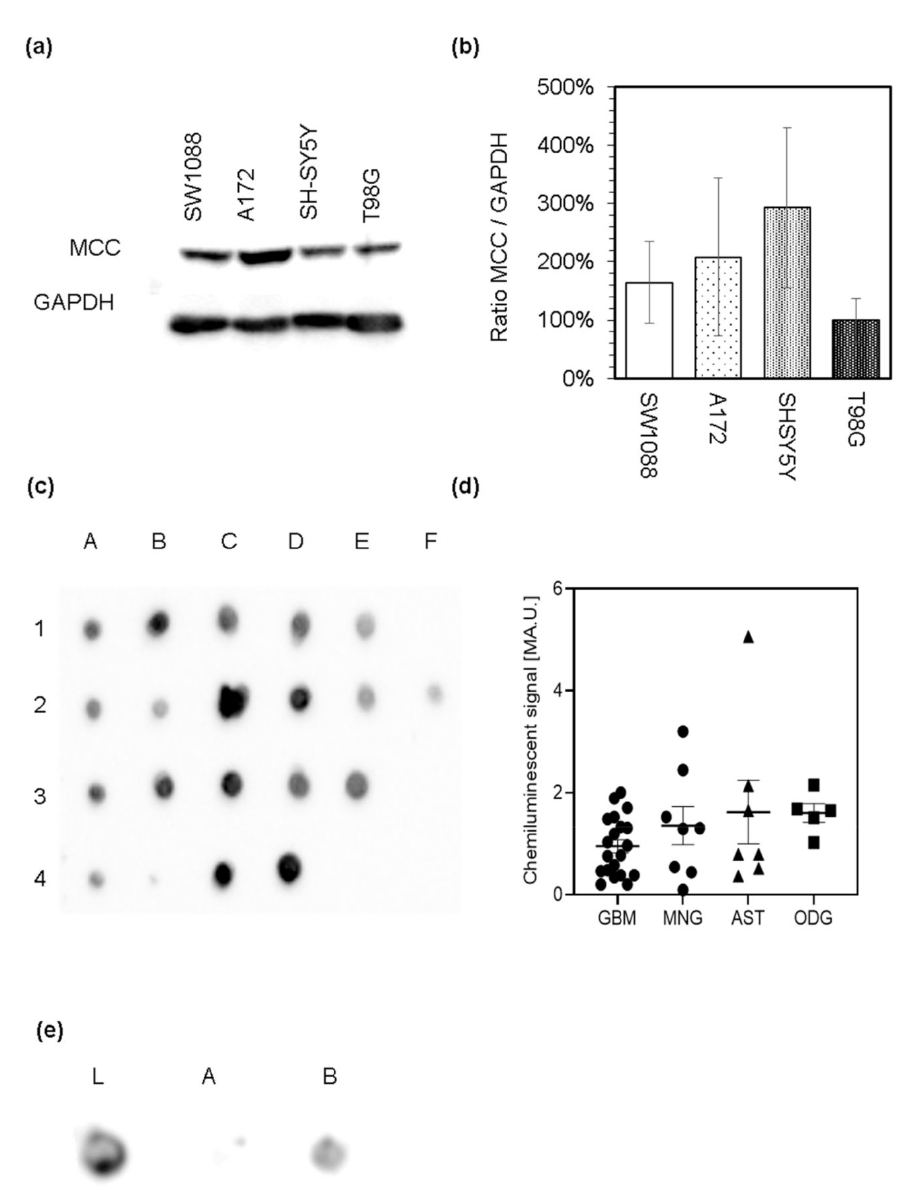
Figure 4. Immunoblotting analysis of the α subunit of 3-methylcrotonyl-CoA carboxylase (MCC) presence among the lysates derived from cultured human glioma (SW1088), glioblastoma (A172, T98G), and neuroblastoma (SH-SY5Y) cells ( a ). Relative expression levels of α subunit of MCC in different cell types was estimated by densitometry, using GAPDH as an internal standard ( b ) . Protein extracts derived from brain tumor samples were analyzed by the dot blot analysis for the presence of the α subunit of MCC. Protein extracts derived from glioblastoma multiforme samples (A1–E1), astrocytoma (A2–F2), oligodendroglioma (A3–E3), and meningioma (A4–D4) were spotted on the nitrocellulose membrane and probed with rabbit antiserum against MCC and subsequently with affinity-purified anti-rabbit IgG molecules covalently linked to horseradish peroxidase ( c ). Relative expression levels of MCC in different tumor lysates were estimated by densitometry ( d ). Protein extract derived from the glioblastoma multiforme sample was used to evaluate the specificity of the MCC signal. On the nitrocellulose membrane, proteins of glioblastoma lysate before ( e ; L) or after removal of biotin-containing proteins with streptavidin-agarose beads (( e ); A) and also the proteins released from the complex with streptavidin after elution with biotin (( e ); B) were